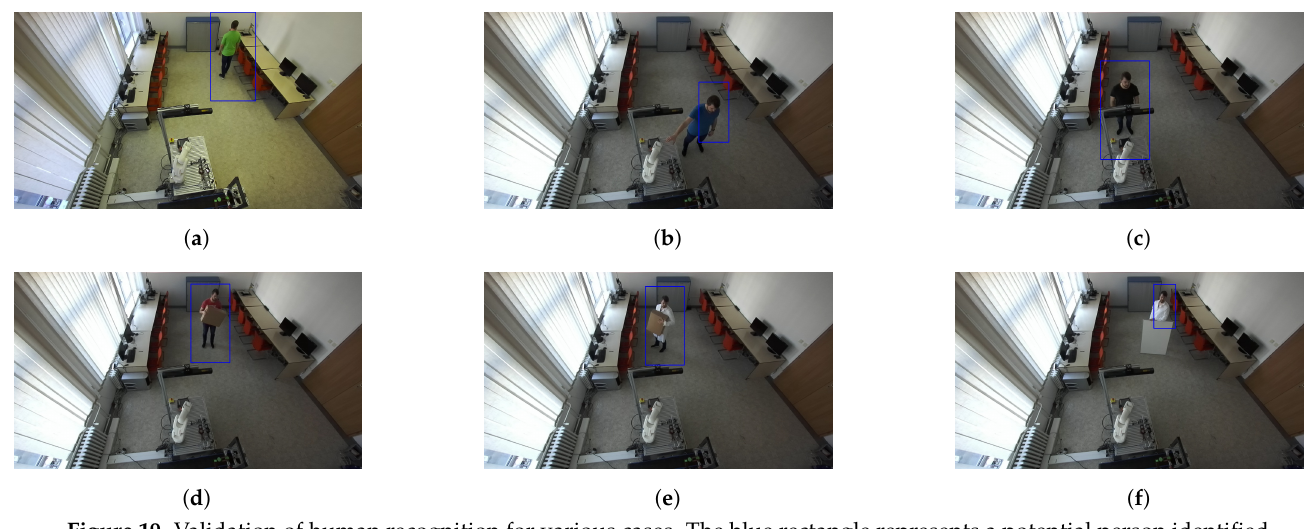
Figure 19. Validation of human recognition for various cases. The blue rectangle represents a potential person identified using the HOG algorithm. ( a ) A person wearing a green shirt. ( b ) A person wearing a blue shirt. ( c ) A person wearing a black shirt who is partially visible. ( d ) A person wearing a red shirt holding a small box. ( e ) A person wearing a white coat and holding a big box. ( f ) A person wearing a white coat behind a